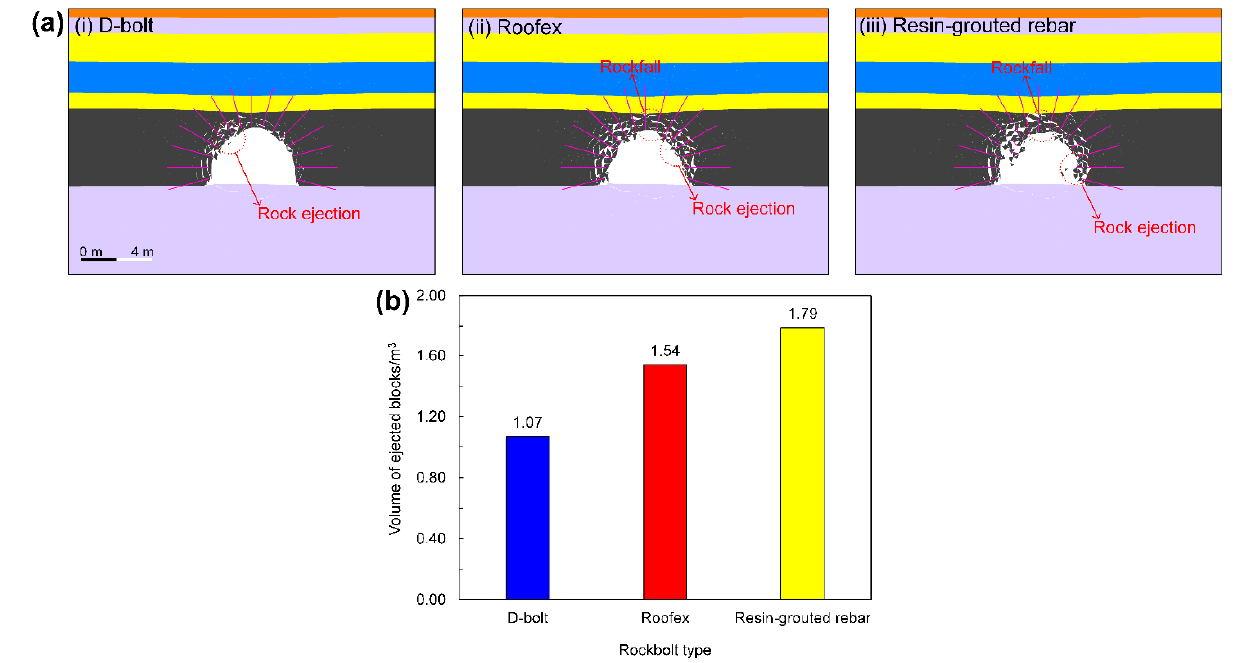
Figure 16. ( a ) Macroscopic failure patterns of the tunnel supported by different types of rockbolts. ( b ) is the volume of ejected rock blocks of the tunnel induced by rockbursts.